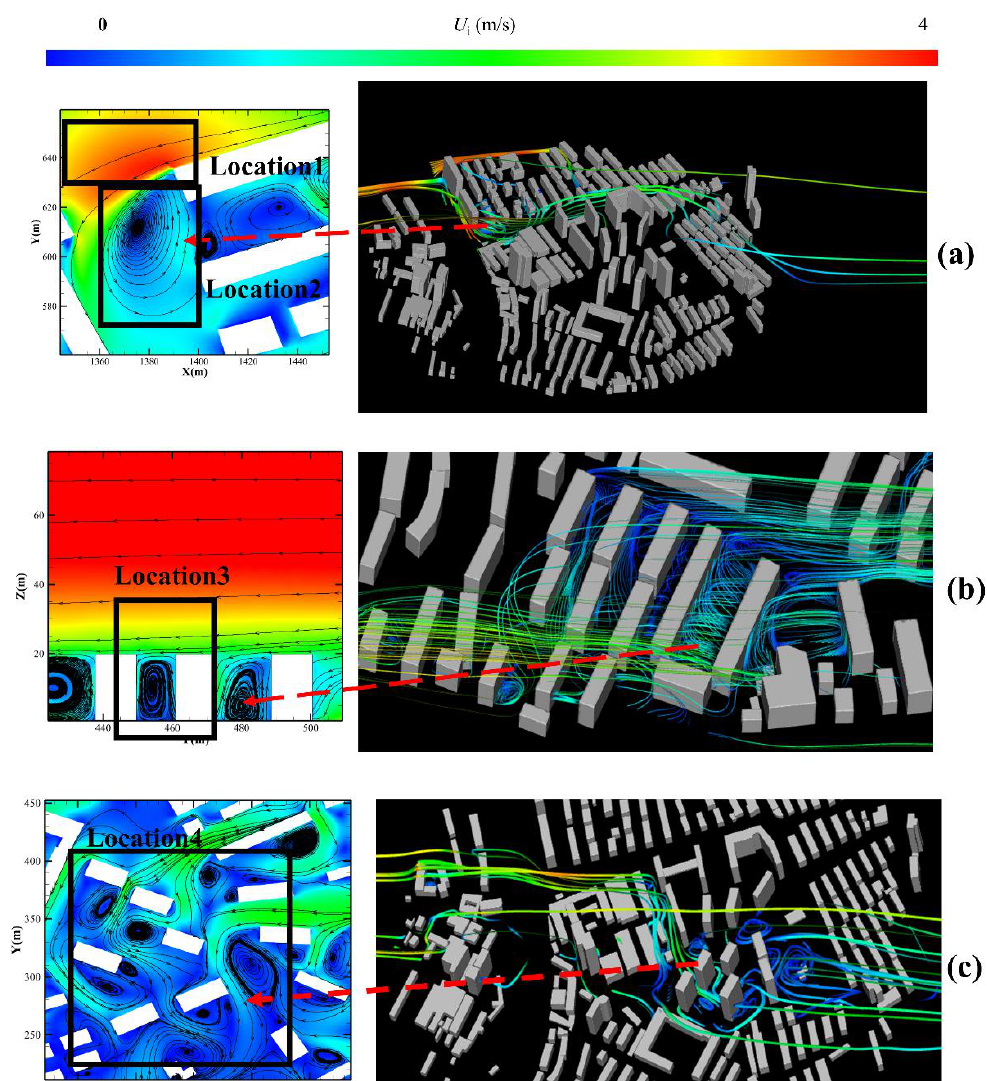
Figure 9. Horizontal contour plots of U i and 3D streamline in street canyons: ( a ) Corner vortex; ( b ) Vertical vortex; ( c ) Horizontally rotating canyon vortices.